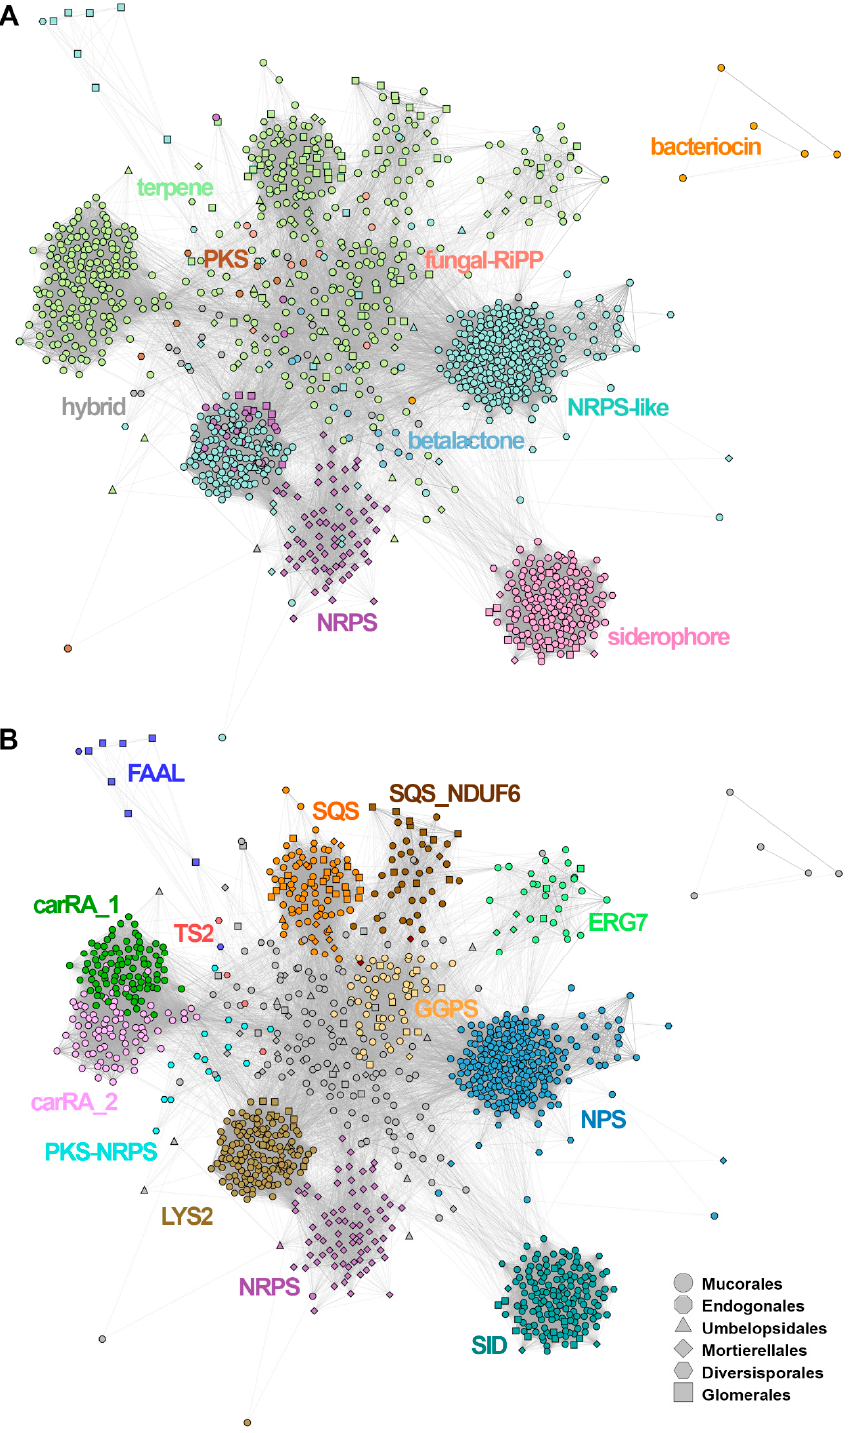
Figure 3. Cytoscape/MultiGeneBlast clustering of the identified SMCs, coloured according to ( A ) the predicted cluster type (AntiSmash classification rules) and ( B ) gene families: LYS2-a, aminoadipate reductases; SID, siderophore synthases (nonribosomal); SQS, squalene synthase; SQS_NDUF6, squalene synthase (homologous to NDUF6); GGPS, geranyloger- anyl phosphate synthetase; ERG7, terpene synthase (homologous to lanosterol synthase); TS2, terpene synthase type 2, carRA_1, carRA_2-bifunctional lycopene cyclases/phytoene desaturases; NPS, aryl-forming reductase (nonribosomal peptide synthase-like) NRPS’, nonribosomal peptide synthase; PKS, polyketide synthase; PKS-NRPS, hybrid polyke- tide/nonribosomal peptide synthase; FAAL, fatty acid acyl-CoA AMP